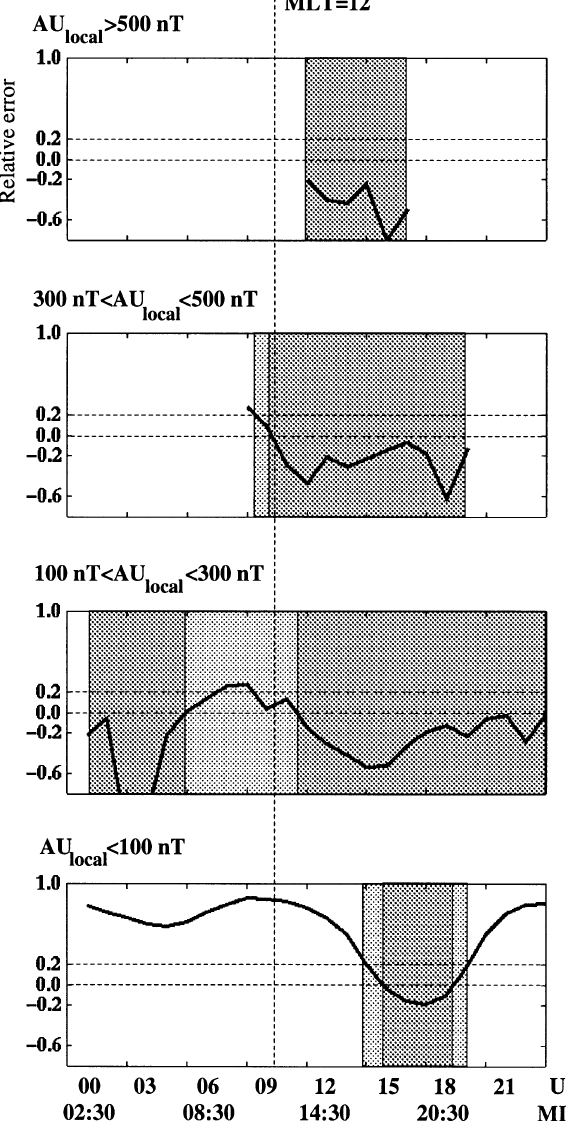
Fig. 6. Activity dependence of the average relative errors between the global and local A ” . The data have been binned according to local activity. The UT-periods when the error is below 0.2 and below 0 (i.e. the local chain sees stronger activity than the global one) are marked with lighter and darker shadings ,